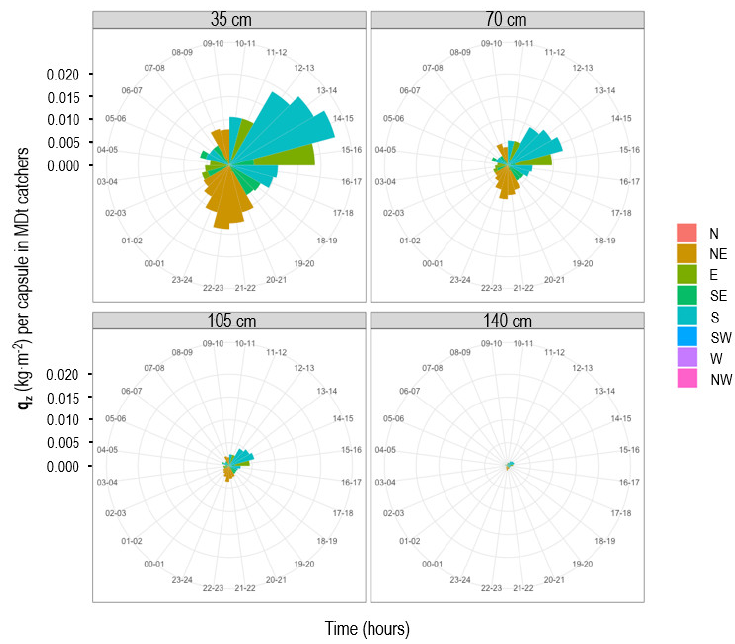
Figure 6. Hourly distribution of sediment flow monitored with load cells.